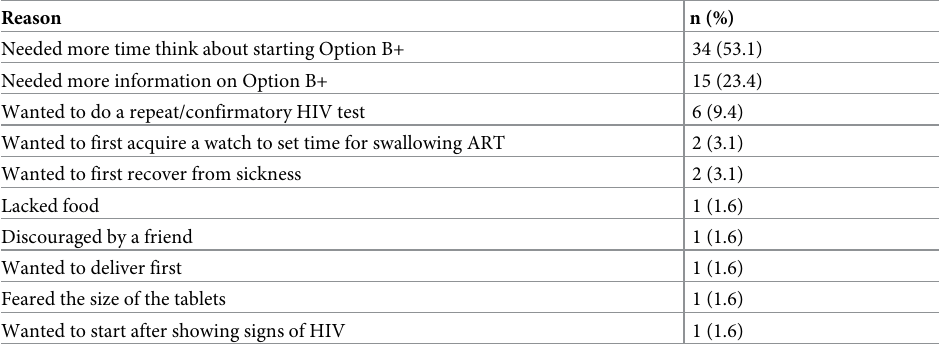
Table 6. Reasons for not being ready to start ART at the time of prescription (n =